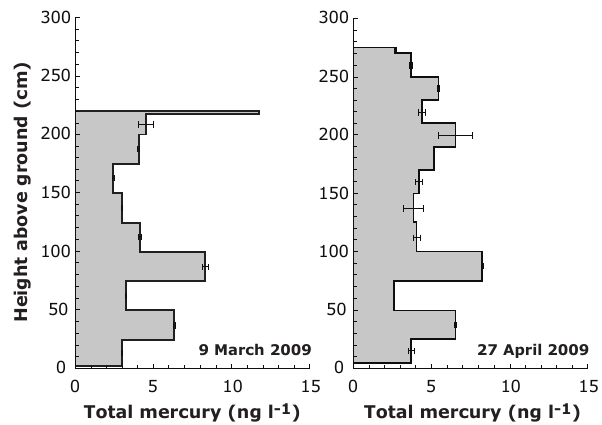
Fig. 7. Snow depth profiles of THg in snow collected in the vicinity of the gradient tower in an open area. Every sample was measured three times and error bars (which are too small in some cases to be readable) indicate corresponding standard